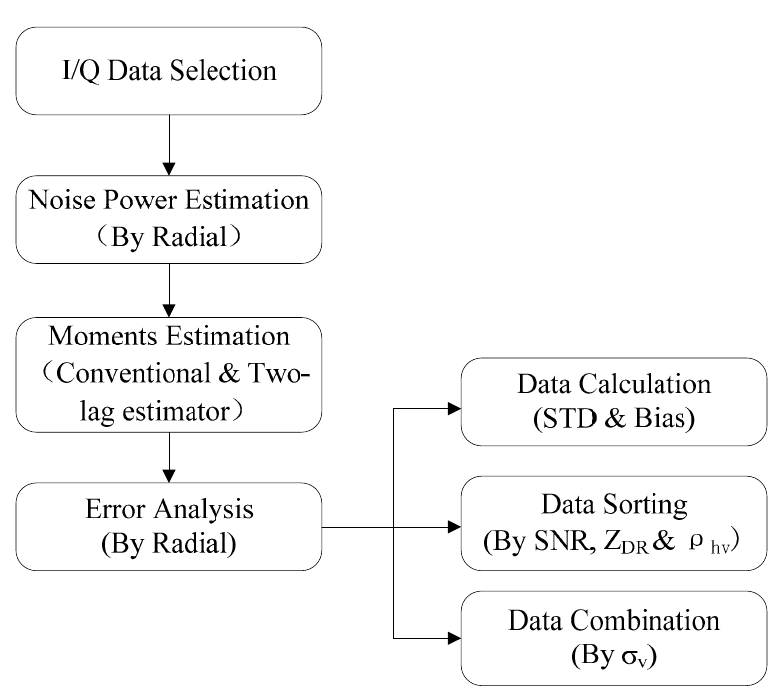
Figure 1. Flowchart of error statistic using I/Q data collected by NJU-CPOL.